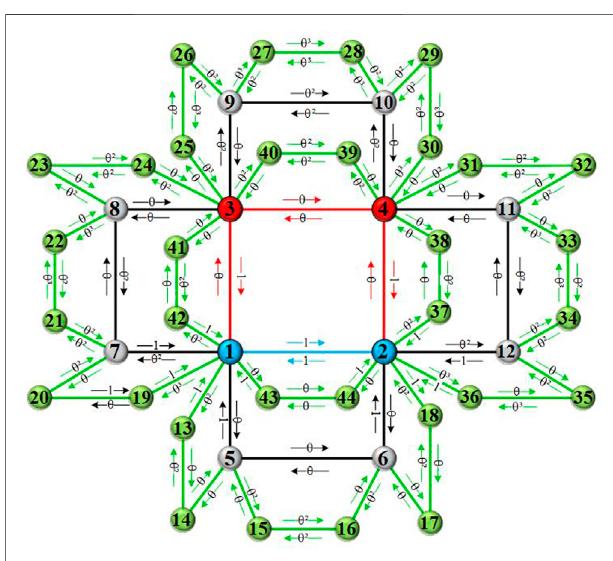
FIGURE 3 | DWEI network at t =